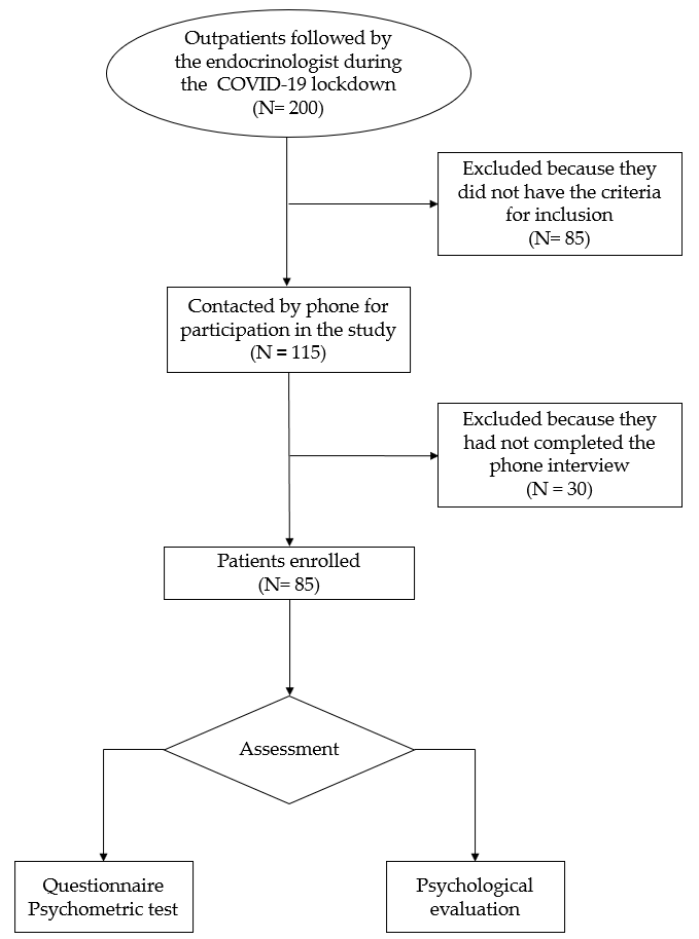
Figure 1. Flow-chart of the patients ’ enrollment.